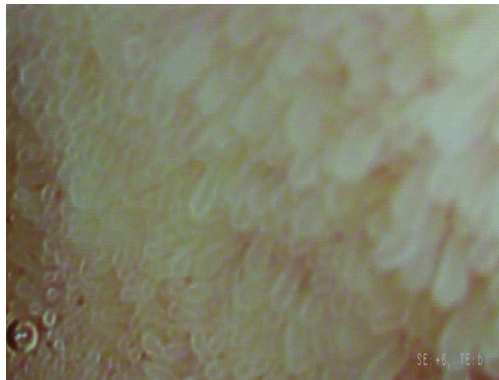
Figure 2: High-magnification endoscopy using i-scan with surface enhancement and tone enhancement clearly visualizes individual intestinal villi with normal shape and size in a patient with quiescent Crohn’s